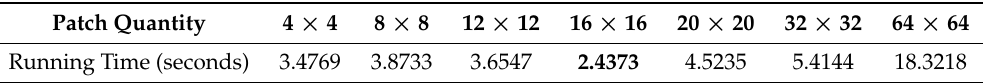
Table 5. Comparison of running time in LIVE II dataset with different patch quantity from 4 × 4 to 64 × 64. The minimum running time is marked in